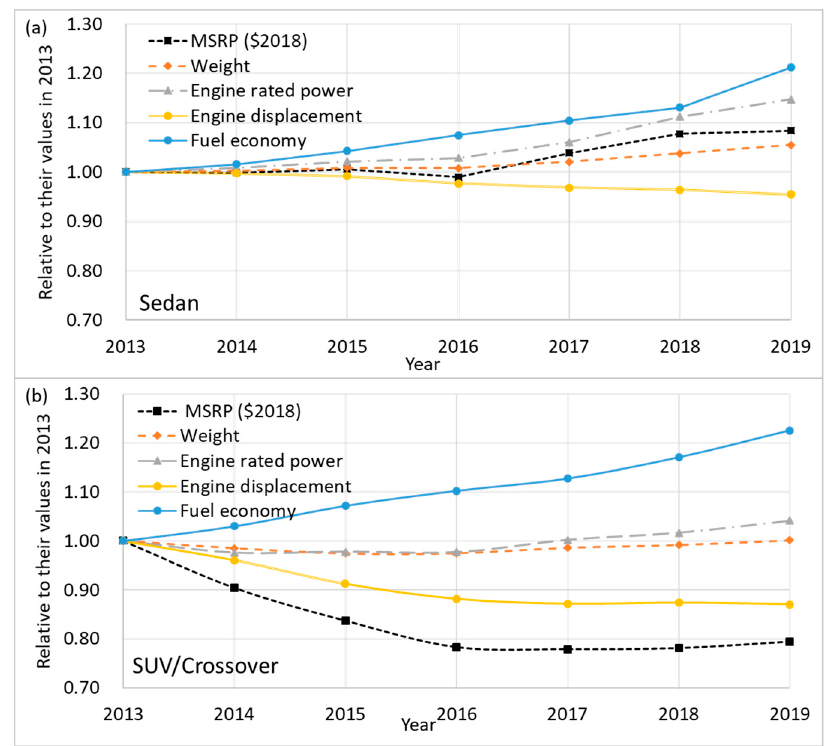
Figure 4. Relative values of major vehicle features in 2013–2019: ( a ) sedan and ( b ) SUV/crossover.